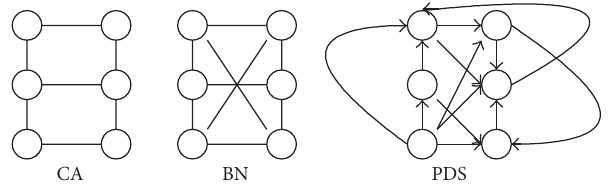
Figure6:Graphicrepresentationofcomparativedependencygraphs for CA, BN, and